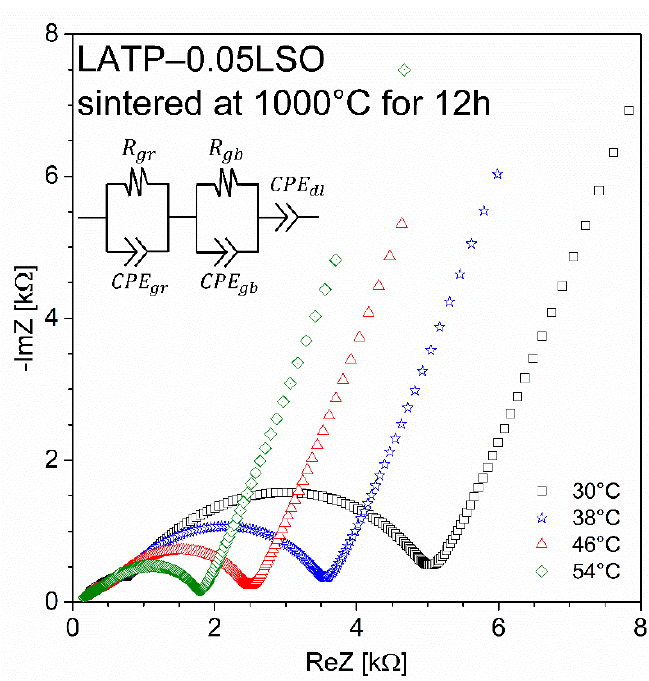
Figure 8. Nyquist plots for the data collected at 30 °C, 38 °C, 46 °C, and 54 °C for LATP–0.05LSO composite sintered at 1000 °C for 12 h. The equivalent circuit modeling the electrical properties of the sintered materials is displayed as inset.